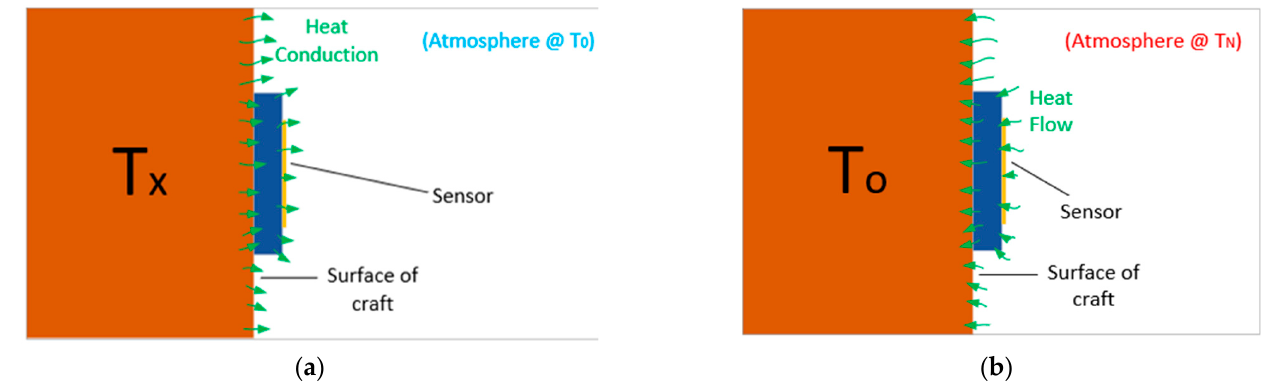
Figure 13. Potential heat sources: ( a ) from the surface, ( b ) from the environment.